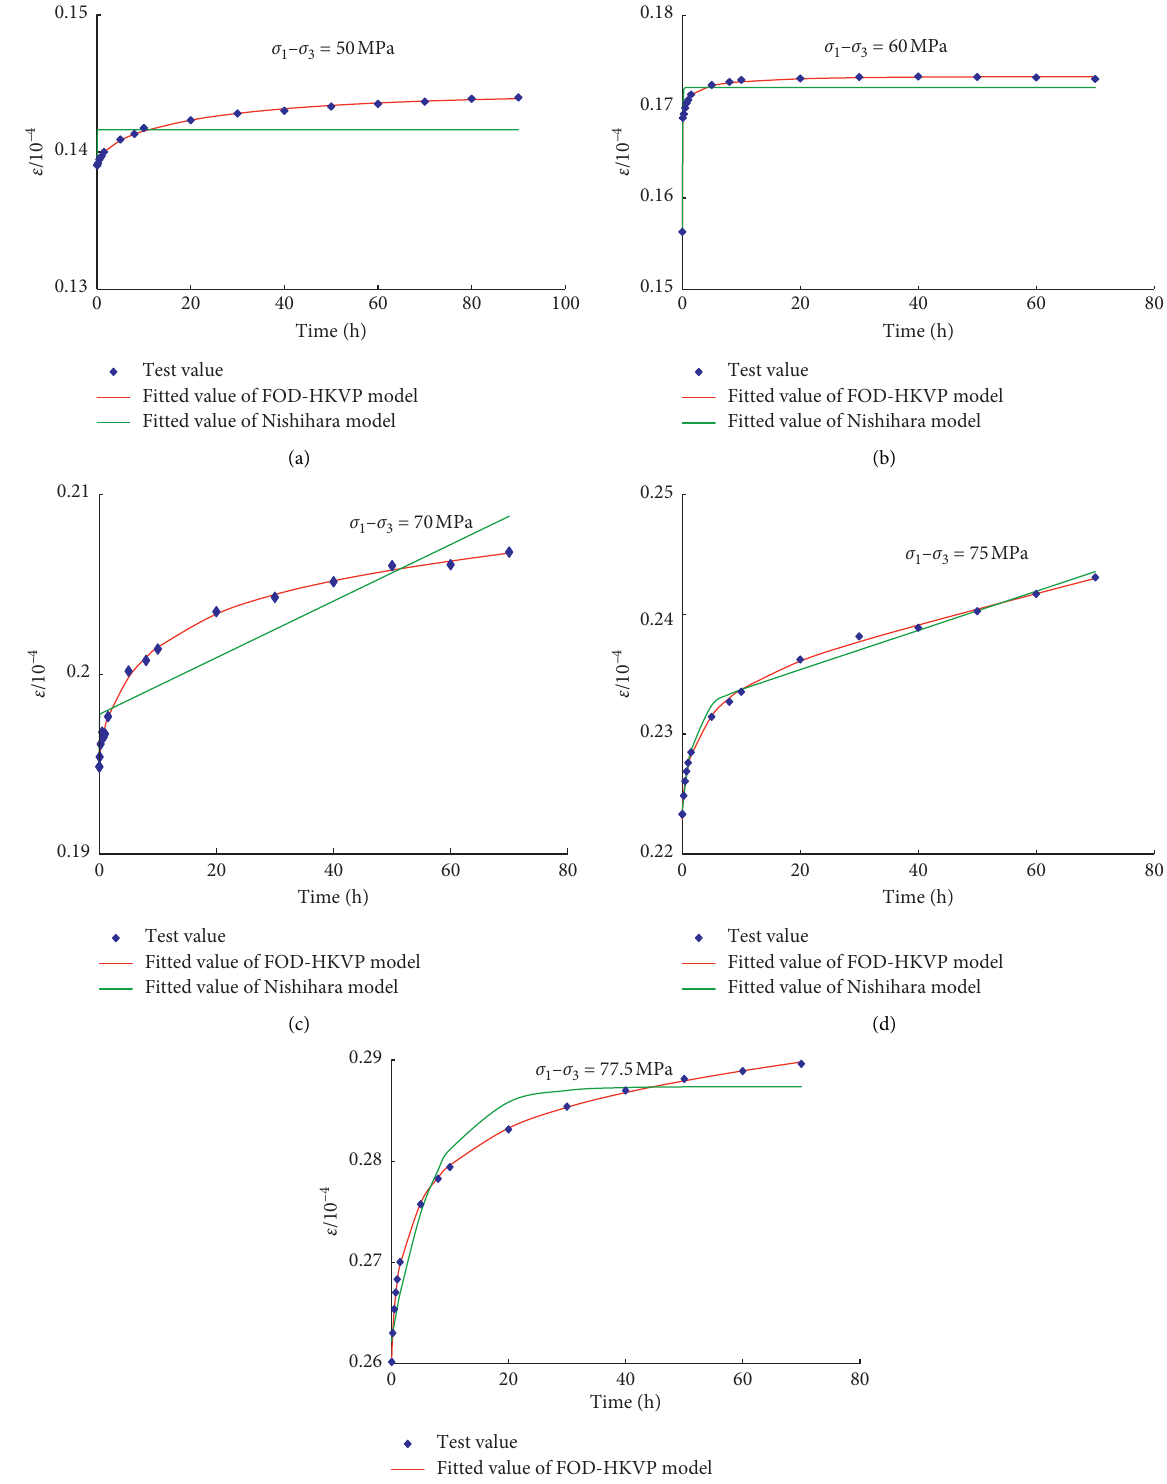
Figure 12: Comparison diagram of fitting results with FOD-HKVP model and the classical Nishihara model. (a) σ (b) σ 1 – σ 3 � 60MPa. (c) σ 1 – σ 3 � 70 MPa. (d) σ 1 – σ 3 � 75MPa. (e) σ 1 – σ 3 �